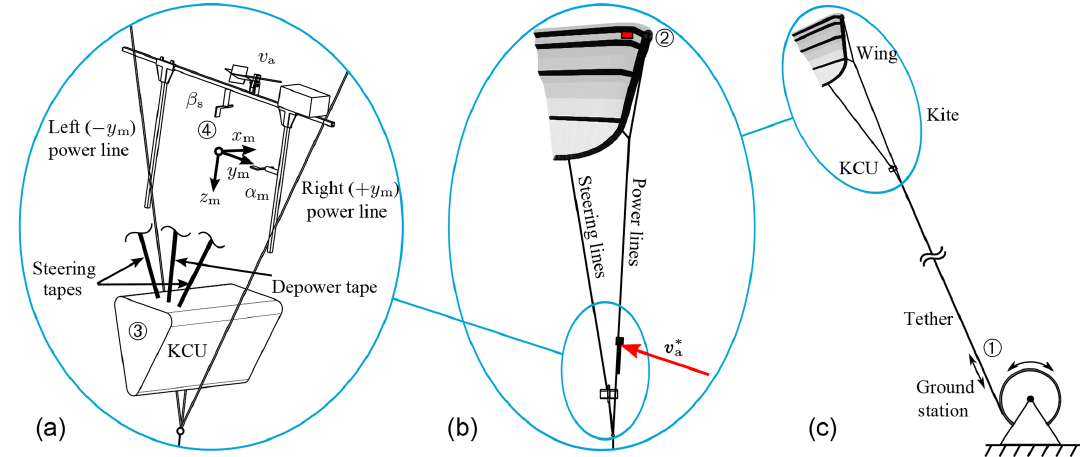
Figure 3. Basic components of the kite power system ( c ) and wing with suspended control unit, together denoted as the kite ( b ); measurement frame attached to the power lines ( a ). Sensor positions: tether force F t and tether reel-out speed v t are recorded at the ground station (1), GPS and IMU modules are mounted on the center strut of the kite (2), and the kite control unit (3) actuates the wing for steering and changing its power state, also measuring the instantaneous lengths of steering and depower tapes; the relative flow sensors for inflow angles α m , β s and apparent wind speed v a are mounted on a rigid frame (4) that is attached to the two power lines connecting to the inflatable leading edge tube of the wing. The depicted velocity v ∗ a is the component of the apparent wind velocity v a projected into the drawing plane.